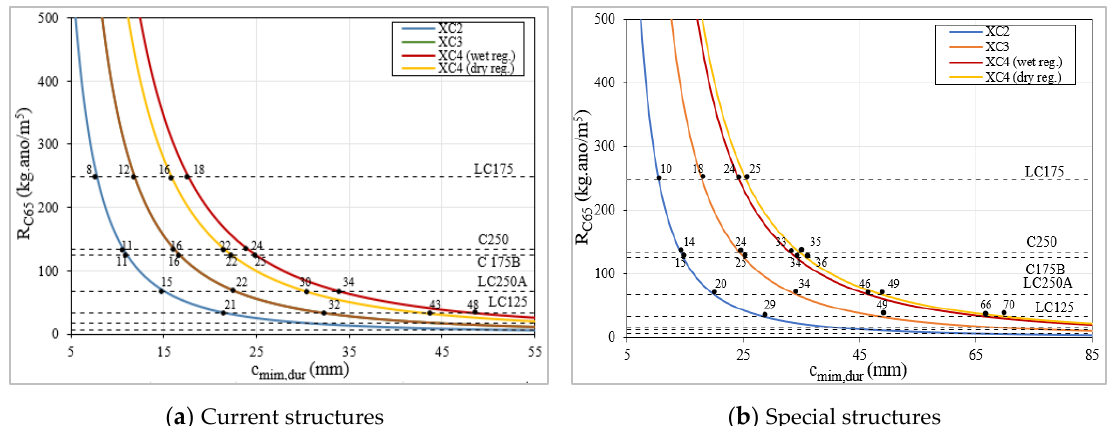
Figure 22. Minimum cover, c min,dur , regarding carbonation.